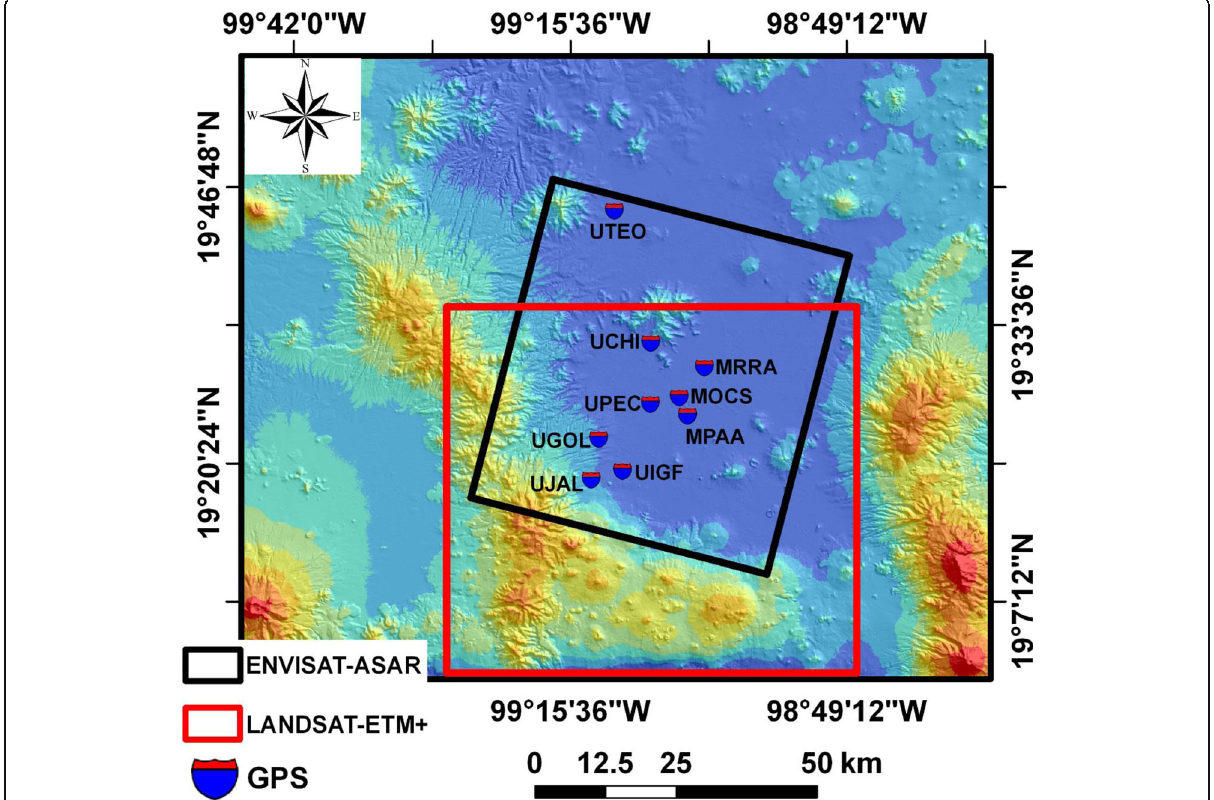
Fig. 1 The black rectangle shows the ENVISAT-ASAR data coverage area in the descending mode. The red rectangle shows the area with the detailed geological map of the study area (see Fig. 3), and Landsat ETM+ imagery from 25/11/2005. The nine installed GPS station locations, also